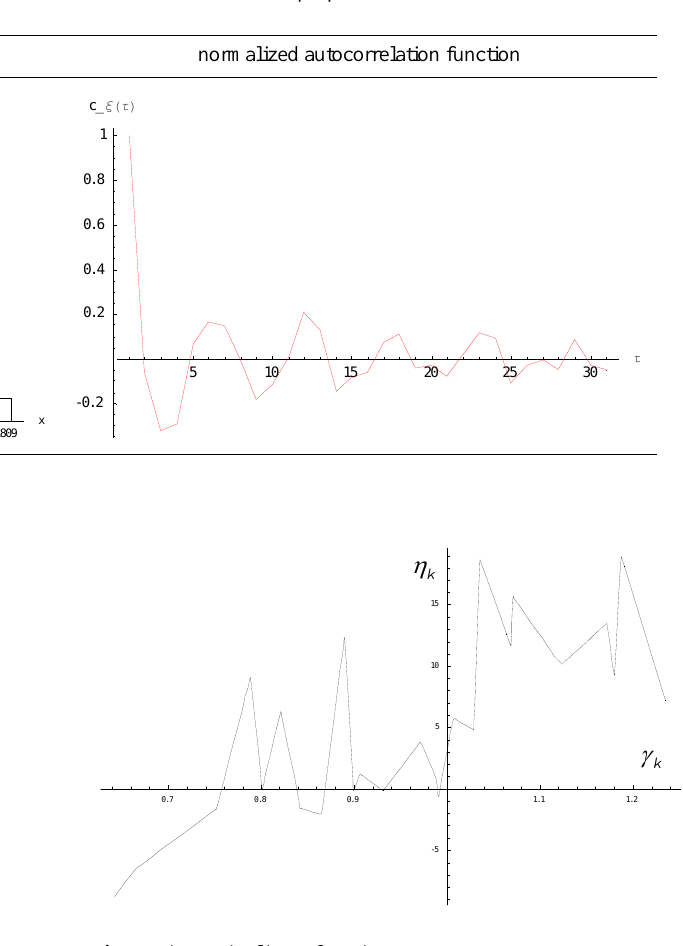
Fig. 7. Piece-wise linear function ν